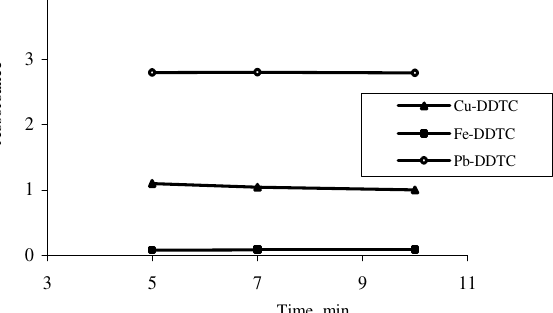
Figure 2. Effect of reaction time on the absorbance of metal-DDTC complex; 5 mgL -1 Cu, Fe and Pb ( n = 6)